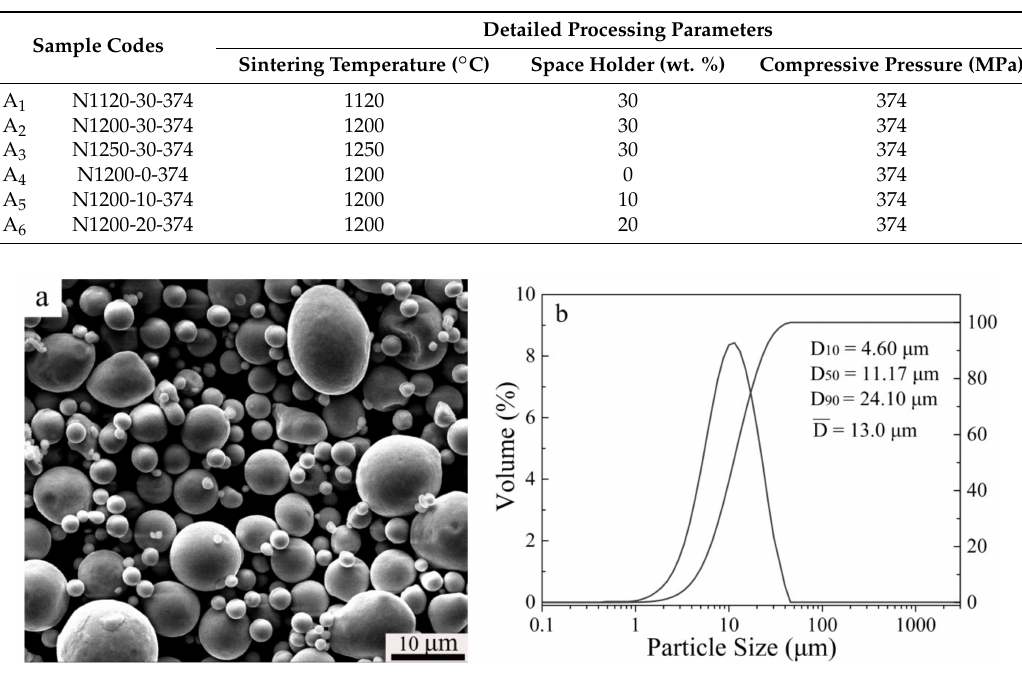
Table 1. Sample codes and corresponding processing parameters.